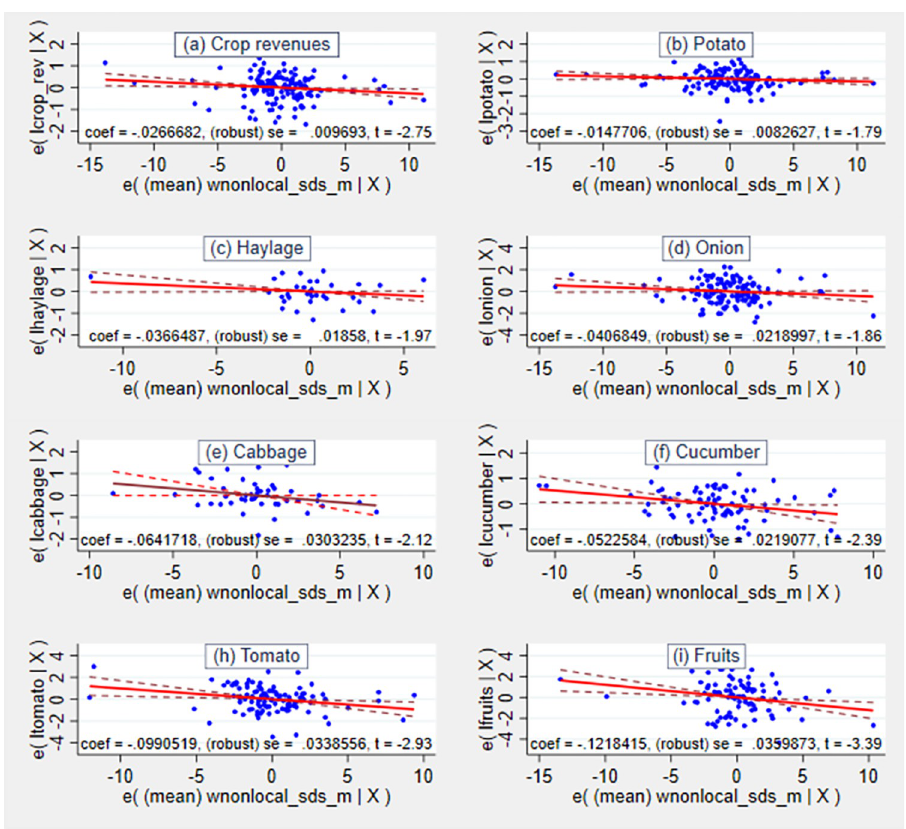
Fig 3. Added-variable plots of the correlation between an SDS conditional on other covariates. Source: Authors’ composition based on the HSES and MIDAS/CEDA